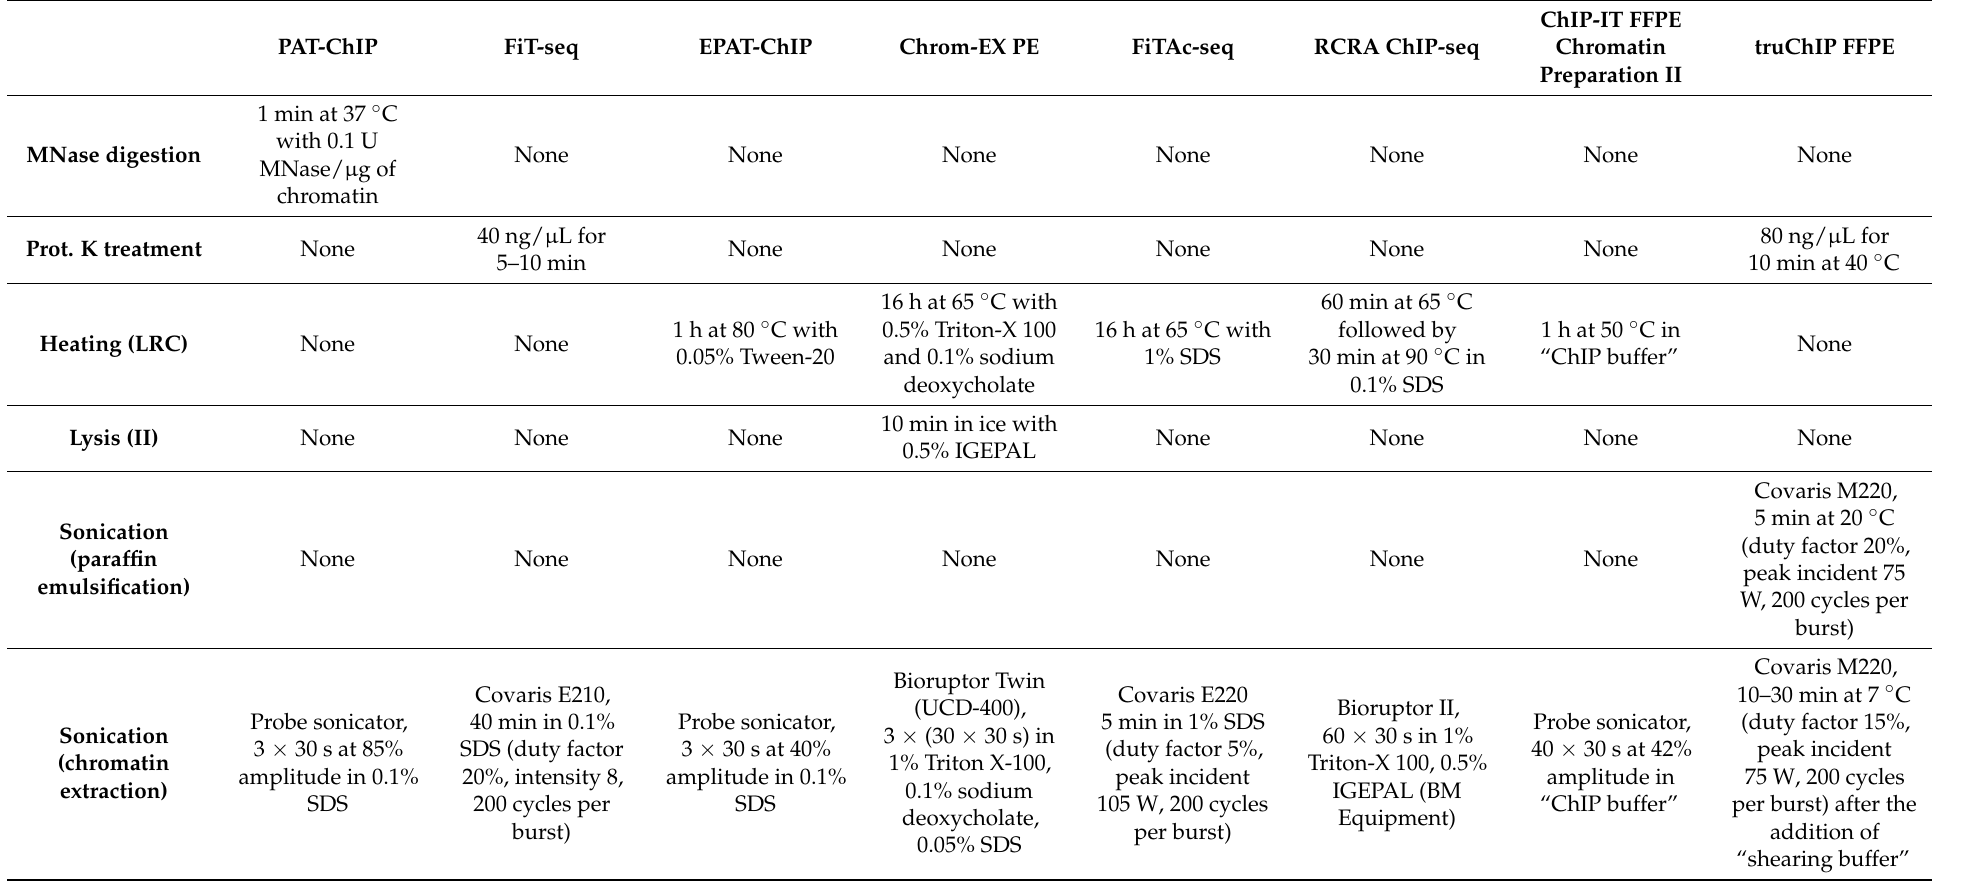
Table 3. Summary of the procedural steps used by the different FFPE-ChIP techniques and kits for chromatin